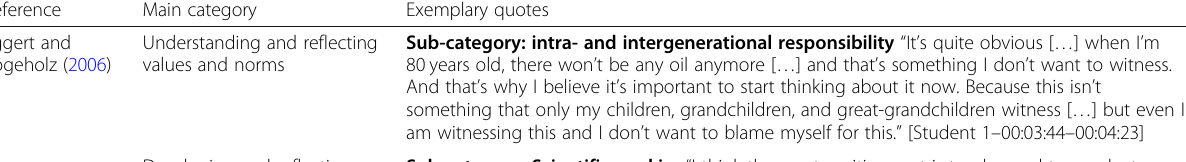
Table 4 Exemplary quotes from the participants